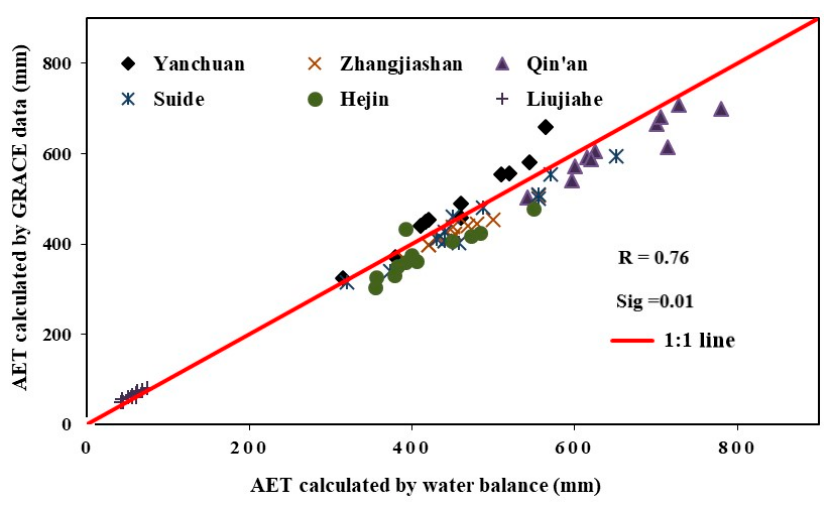
Figure 2. Comparison between the actual evapotranspiration (AET) calculated by water balance and the estimated annual AET based on GRACE data from 2003 to 2014.